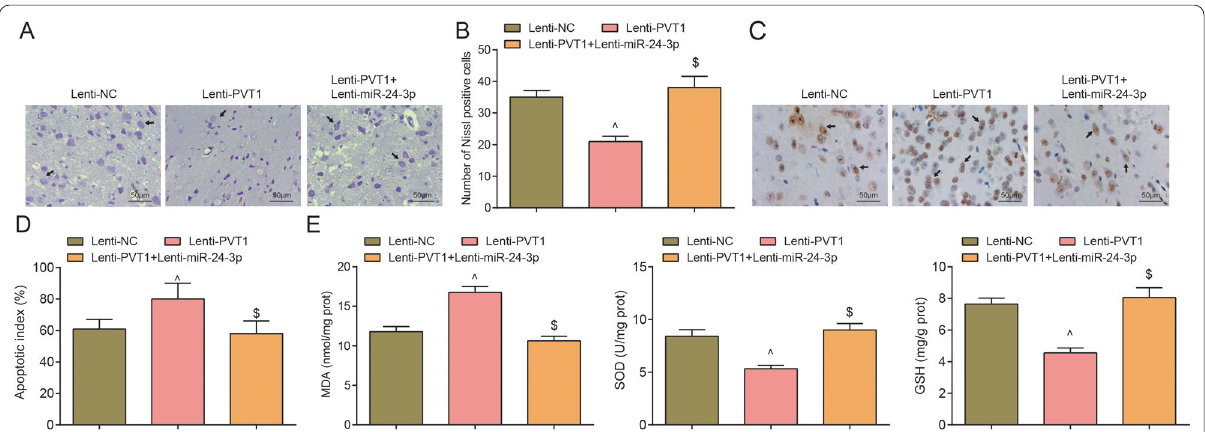
Fig. 6 Restored miR-24-3p abolishes PVT1 overexpression-induced effects on neuronal survival, neuronal apoptosis and oxidative stress in the cerebral cortex of MCAO rats. A / B Nissl staining of neuron survival in each group after PVT1 overexpression and miR-24-3p up-regulation ( 200; × scale bar 50 μm, n 8 rats per group); arrows indicated Nissl bodies; C / D TUNEL staining of neuronal apoptosis in each group after PVT1 = = overexpression and miR-24-3p up-regulation ( 200; scale bar 50 μm, n 8 rats per group; arrows indicated TUNEL-positive cells); E Oxidative × = = stress indicators in the cortex of rats in each group after PVT1 overexpression and miR-24-3p up-regulation (n 8 rats per group); ^ P < 0.05 = compared with the Lenti-NC group; $ P < 0.05 compared with the Lenti-PVT1 group